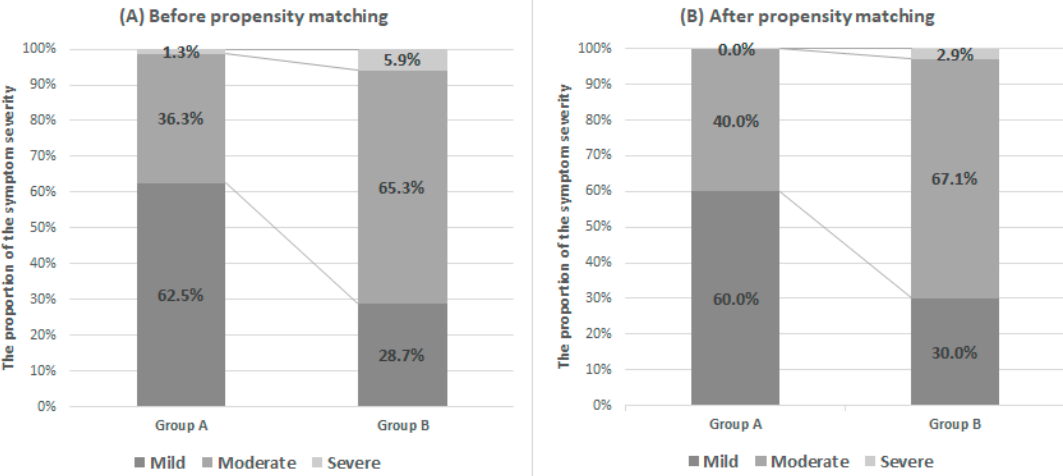
Figure 4. Distribution of subjects according to symptom severity using IPSS in each group before ( A ) and after ( B ) propensity score matching. In the IPSS system, the banding of symptom severity